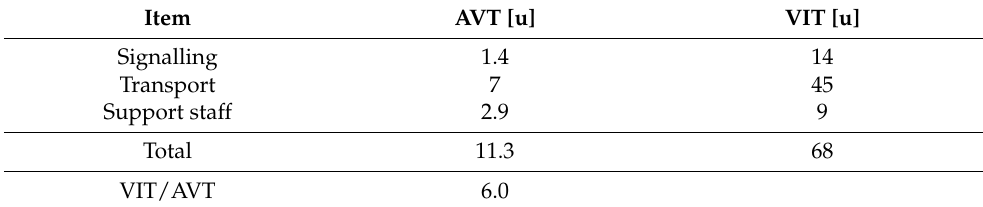
Table 5. Representative cost of dynamic tests using OSP configurations.